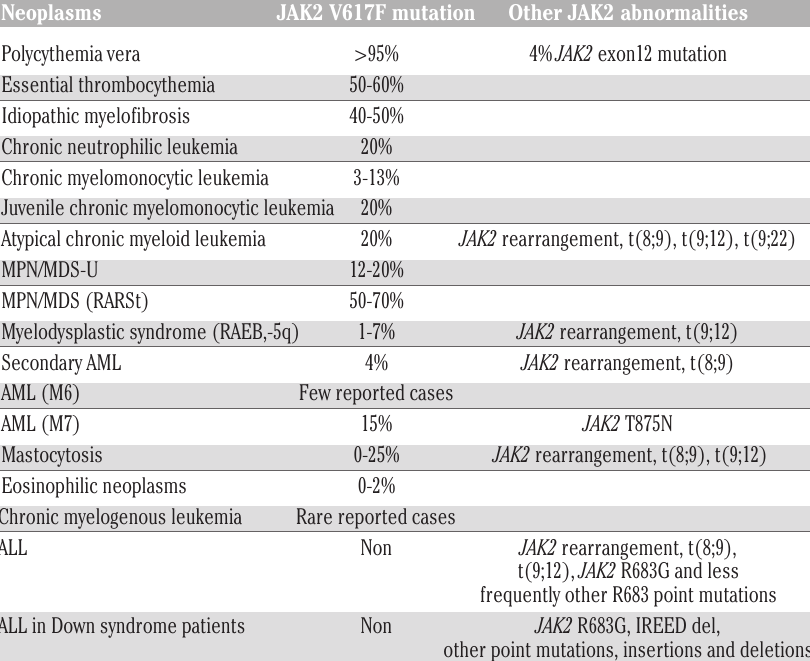
Table 1. Prevalence of JAK2 abnormalities in hematologic